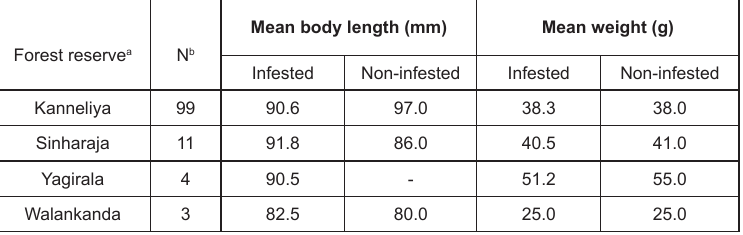
a - Kanneliya and Sinharaja - Man and Biosphere Reserves; Yagirala and Walankanda - forest patches; b - Number of hosts observed. According to the Paired T-Test, there was no significant difference